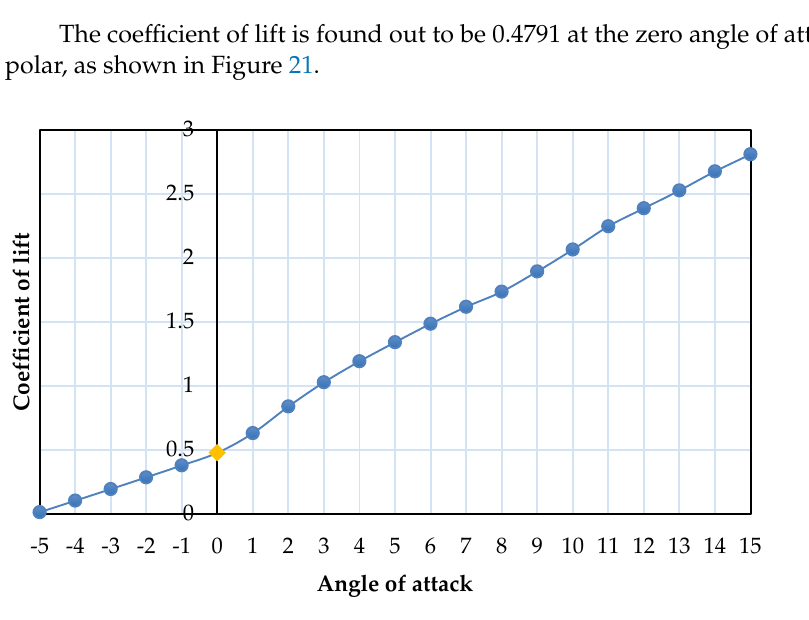
Figure 21. Coefficient of lift (analysis) versus angle of attack.